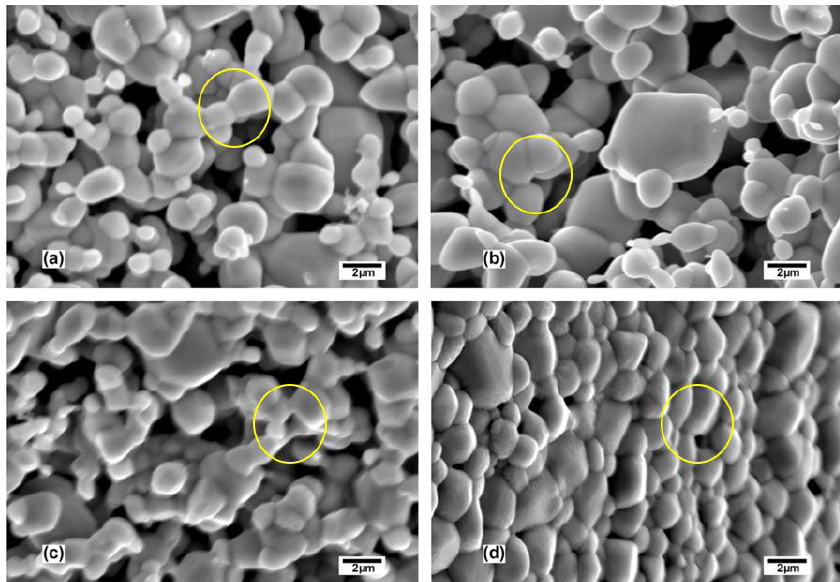
Figure 6. Micrographs of heat-treated ZnO ceramics at 1000 °C/2 h with compositions (a) 60/3, (b) 65/3, (c) 65/1, and (d) 70/1 to evaluate the effect of temperature on